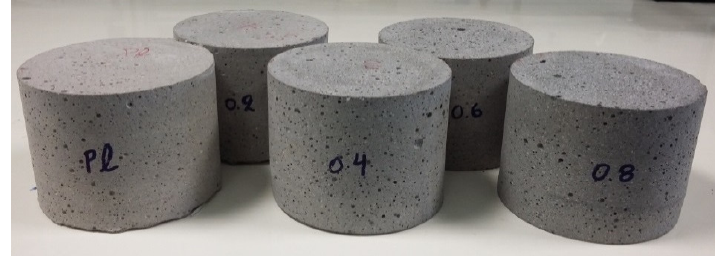
Figure 3. Testing cores drilled off from mortars exposed to accelerated corrosion.